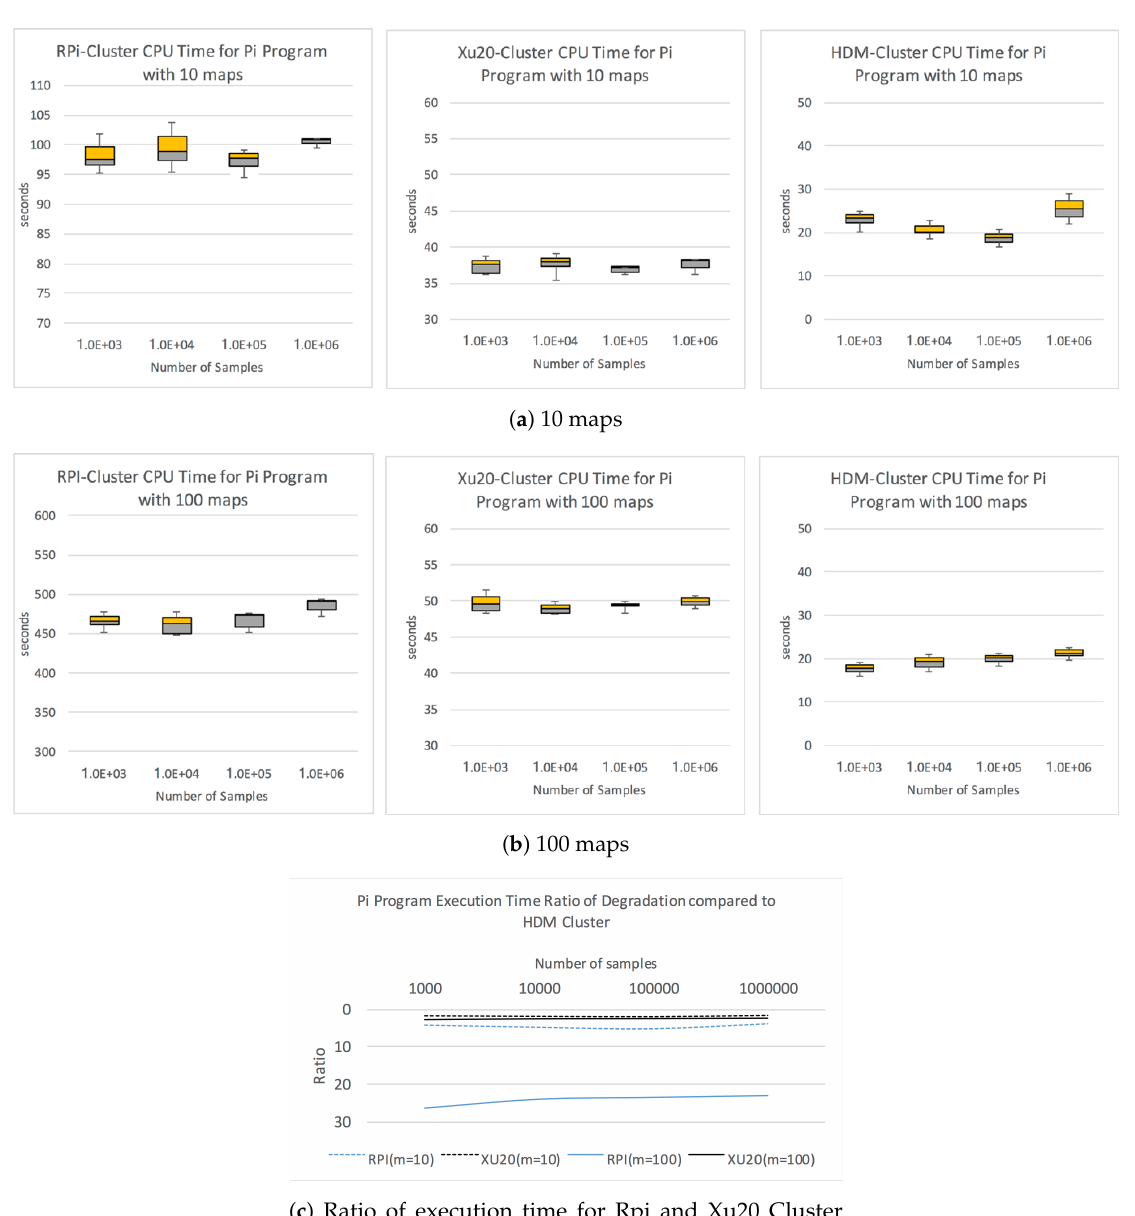
Figure 3. CPU Execution Time versus number of m samples for computation of Pi benchmark in all